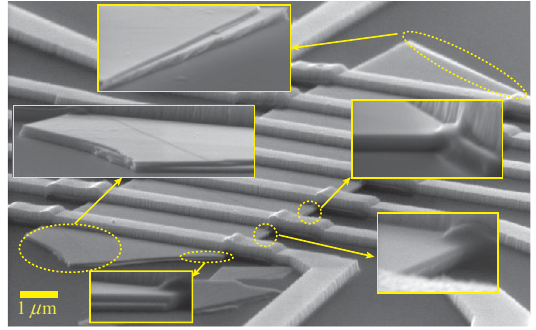
FIG. 6. SEM image of side surfaces of a BSTS flake. Yellow boxes are magnified images for each side part of a BSTS